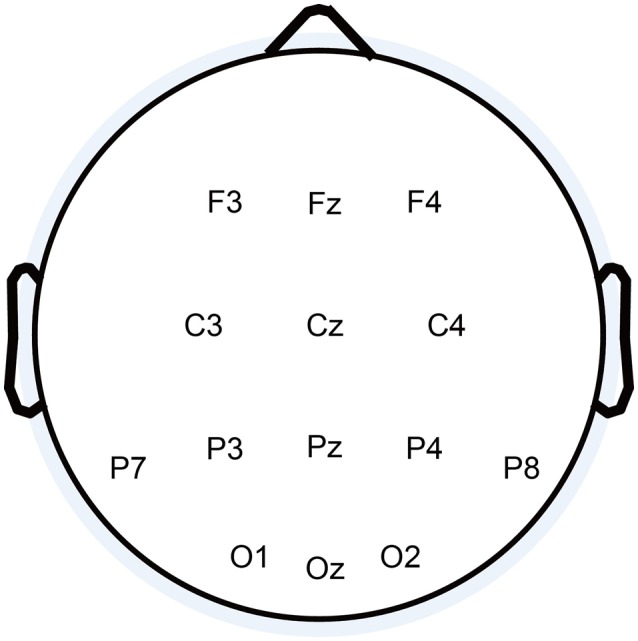
The 16 electrodes used in this study.